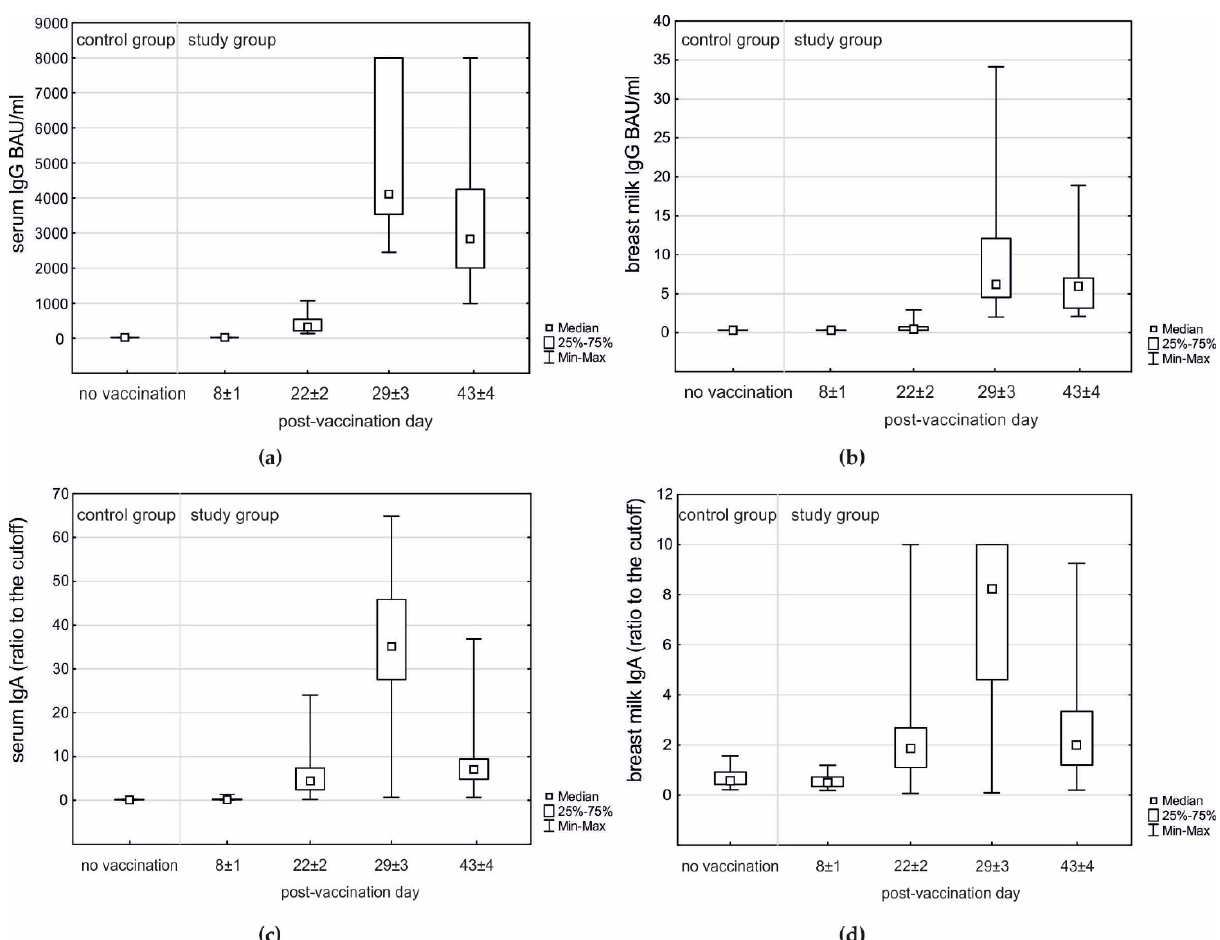
Figure 2. Postvaccination IgG and IgA antibodies in serum and breast milk samples of the study group ( n = 28) compared to unvaccinated control group ( n = 16): ( a ) Serum IgG—day 8 ± 1 (baseline) vs. no vaccination; Mann–Whitney p = 0.152; days 8 ± 1, 22 ± 2, 29 ± 3, and 43 ± 4; Friedman’s rank test p < 0.001 with post-hoc all pairwise comparisons p < 0.05. ( b ) Breast milk IgG—day 8 ± 1 (baseline) and no vaccination below detection limit; days 8 ± 1, 22 ± 2, 29 ± 3, and 43 ± 4; Friedman’s rank test p < 0.001 with post-hoc all pairwise comparisons p < 0.05. ( c ) Serum IgA—day 8 ± 1 (baseline) vs. no vaccination; Mann–Whitney p = 0.129; days 8 ± 1, 22 ± 2, 29 ± 3, and 43 ± 4; Friedman’s rank test p < 0.001 with post-hoc all pairwise comparisons p < 0.05. ( d ) Breast milk IgA—day 8 ± 1 (baseline) vs. no vaccination; Mann–Whitney p = 0.371; days 8 ± 1, 22 ± 2, 29 ± 3, and 43 ± 4; Friedman’s rank test p < 0.001 with post-hoc pairwise comparisons p < 0.05, except for no difference between days 22 ± 2 and 43 ± 4.